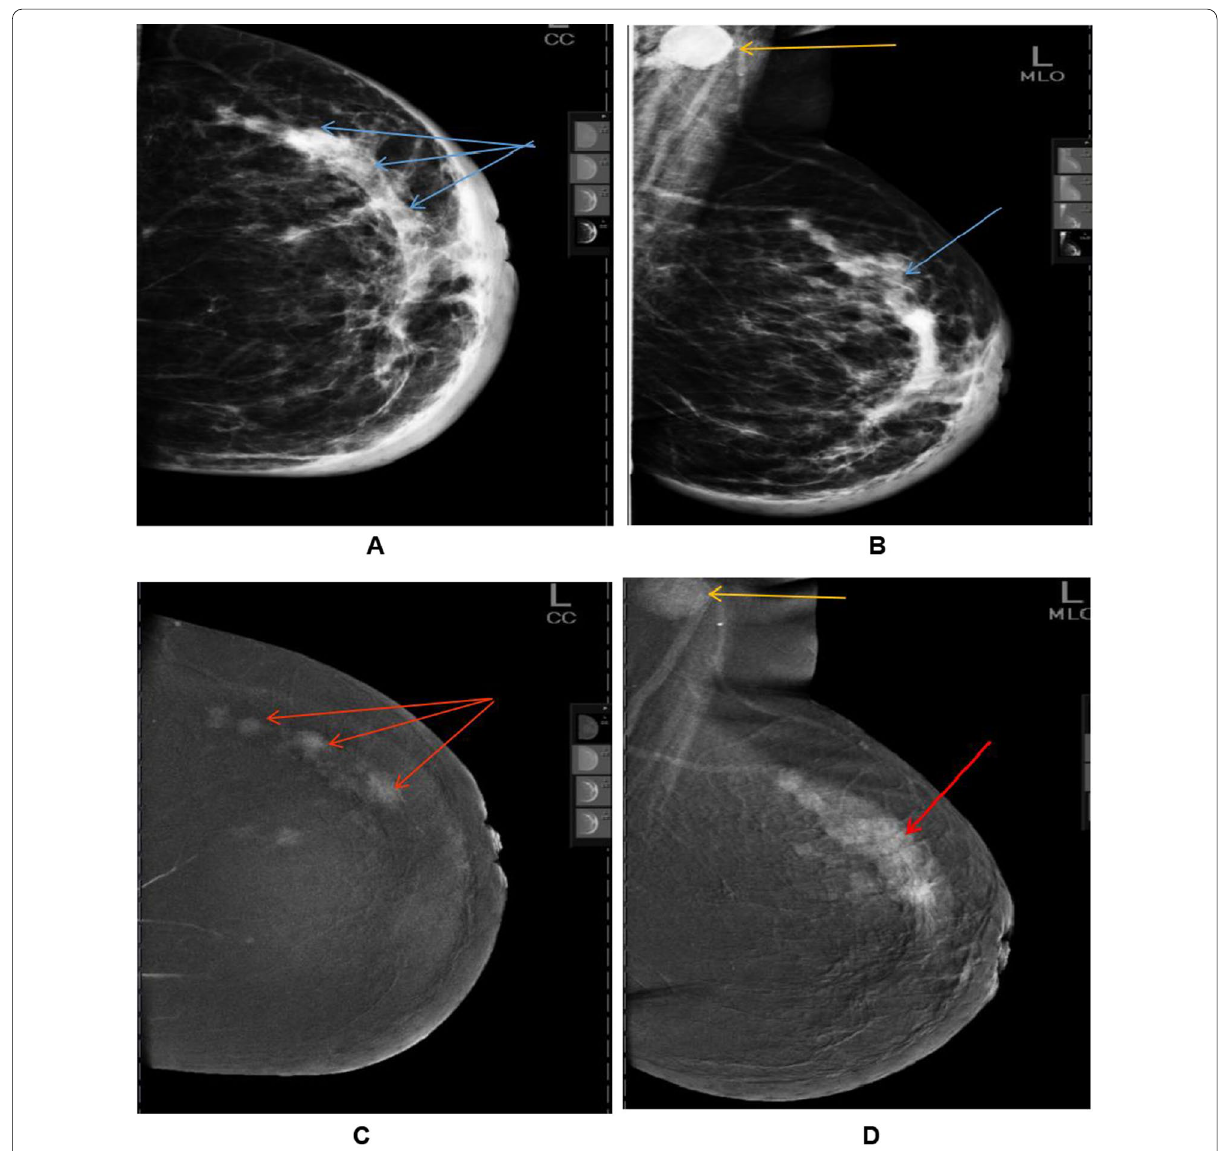
edema pattern with multiple upper outer quadrant (UOQ) ill-defined focal asymmetrical lesions (blue arrows) and left suspicious ipsilateral axillary lymph node LN (yellow arrow). c, d CEDM c CC and d MLO views of the left breast showed UOQ multifocal enhancing speculated masses (red arrows). Pathological diagnosis: Left breast IDC, Grade